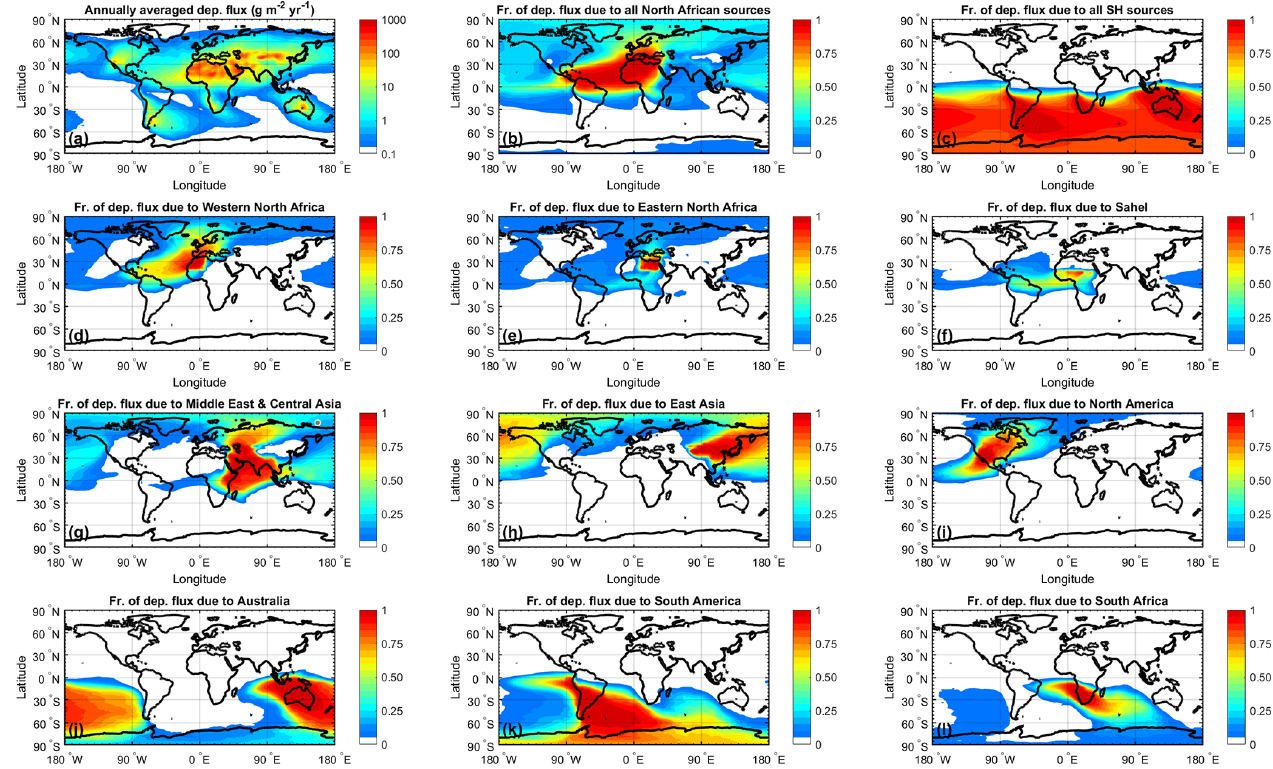
Figure 7. Attribution of the annually averaged deposition flux of PM 20 dust to the world’s main source regions. Panel ordering is identical to Fig. 5, and the seasonally resolved attribution of the dust deposition flux is shown in Figs.